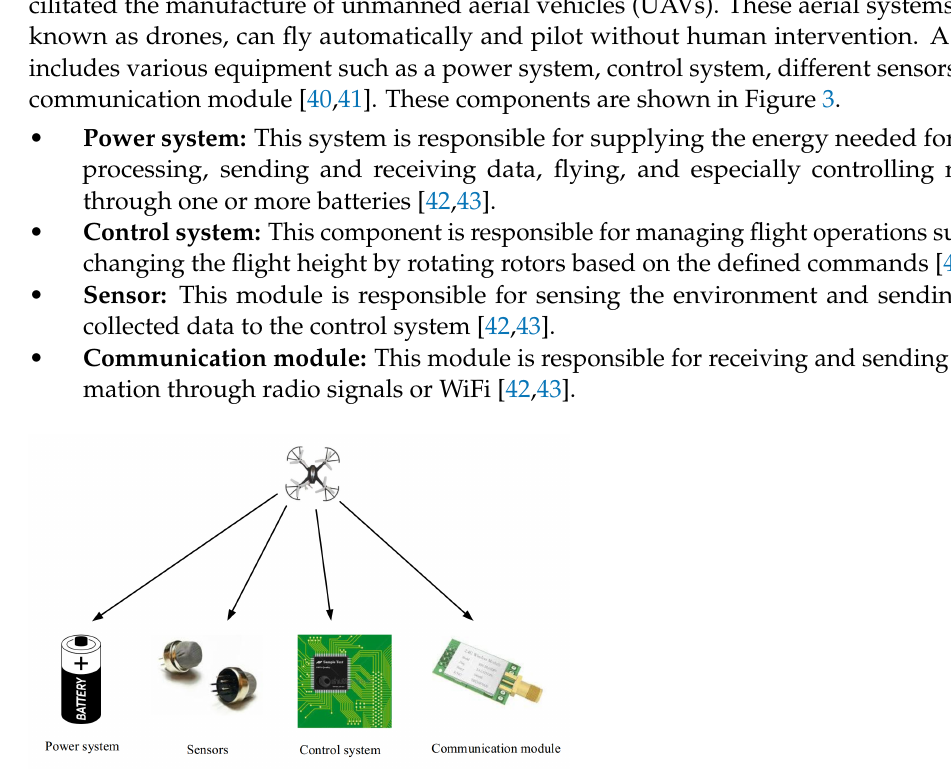
Figure 3. Components of a